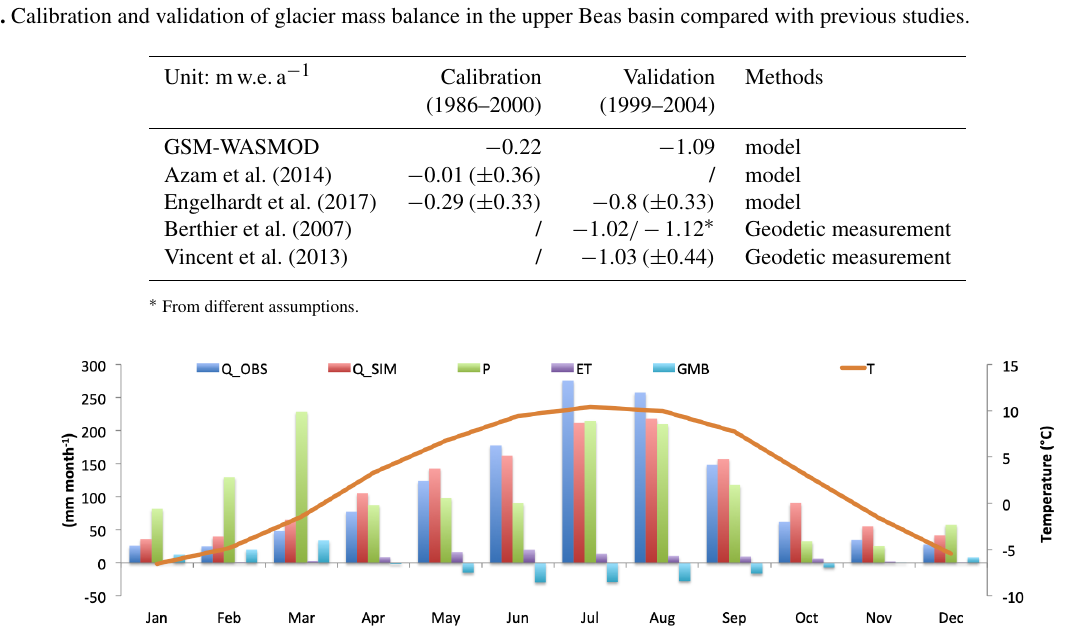
Figure 3. Monthly averages of major water balance terms for the upper Beas basin (1986–2004). The plot shows discharge (Q_SIM), precipitation ( P ), evaporation (ET), glacier mass balance (GMB), observed discharge (Q_OBS) (on the primary axis on the left-hand side), and temperature ( T ) (on the secondary axis on the right-hand